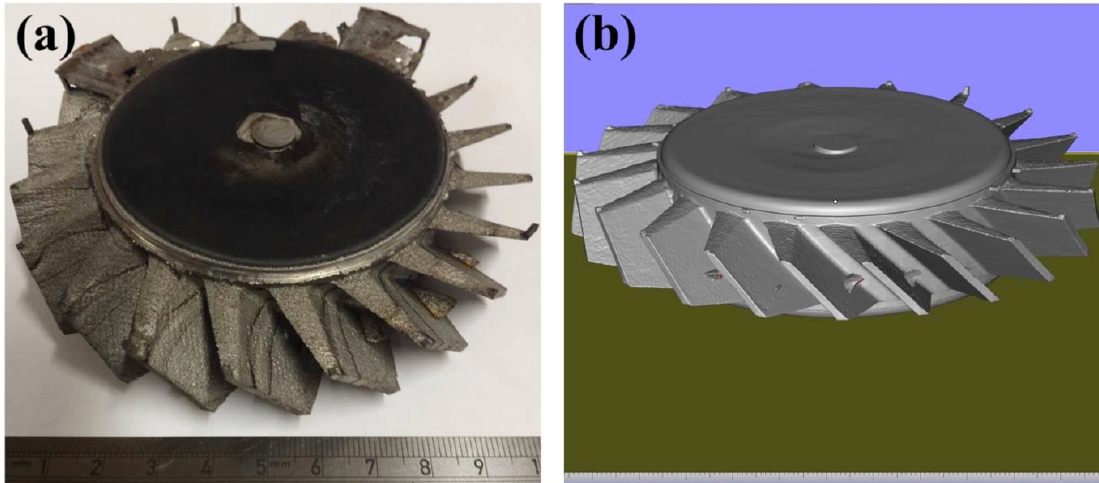
Figure 13. ( a ) The image of the second oversized Fe-tooling SLM/HIP blisk; ( b ) 3D image of the second oversized Fe-tooling SLM/HIP blisk scanned using a GOM optical 3D scanner.